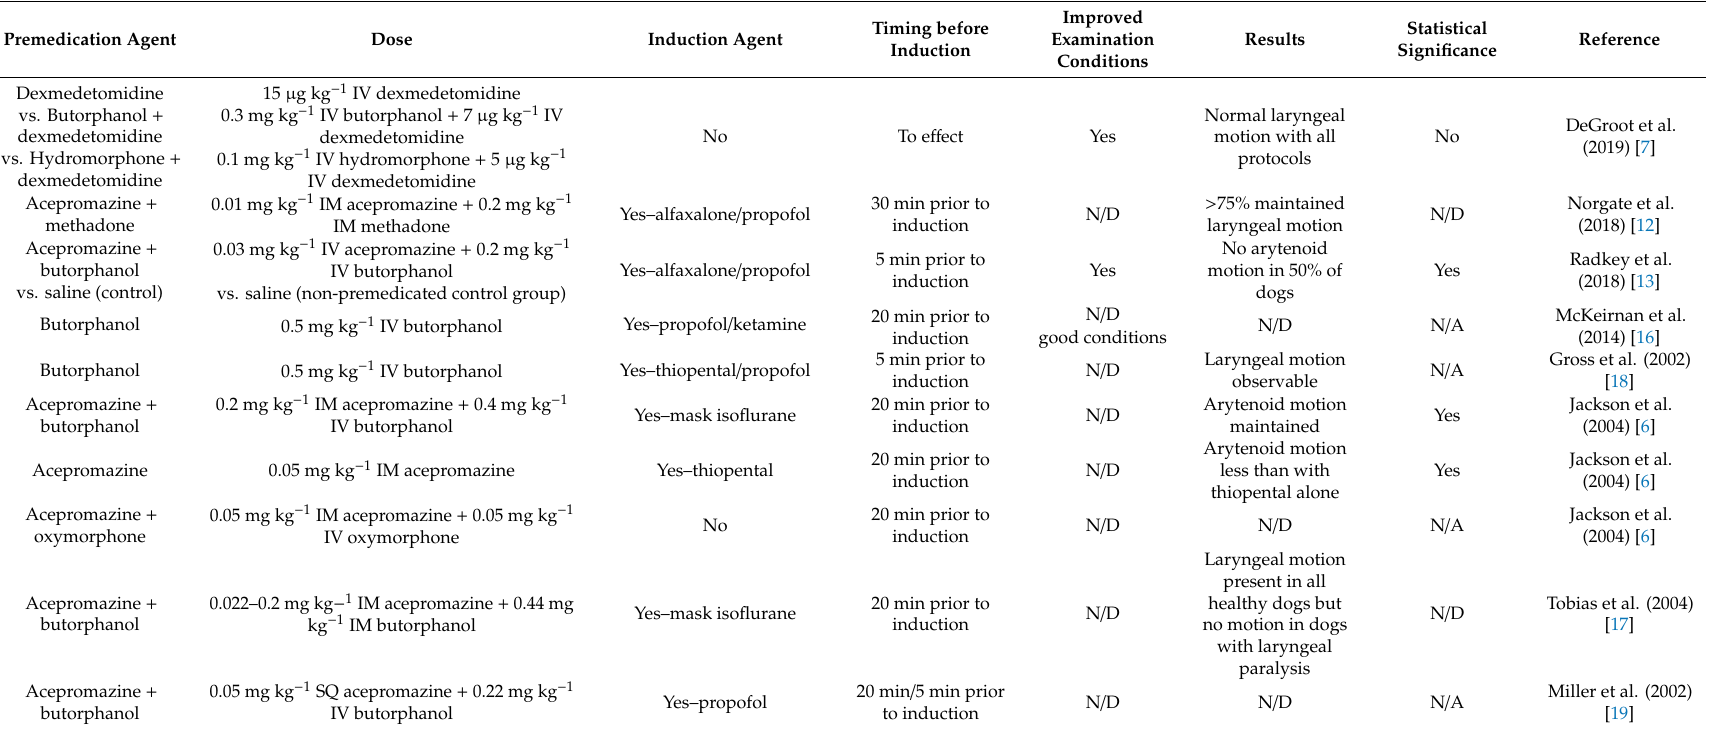
Table 2. Characteristics and study design features from 8 studies evaluating the e ff ects of premedication on laryngeal motion in dogs. Premedication Agent Dose Induction Agent